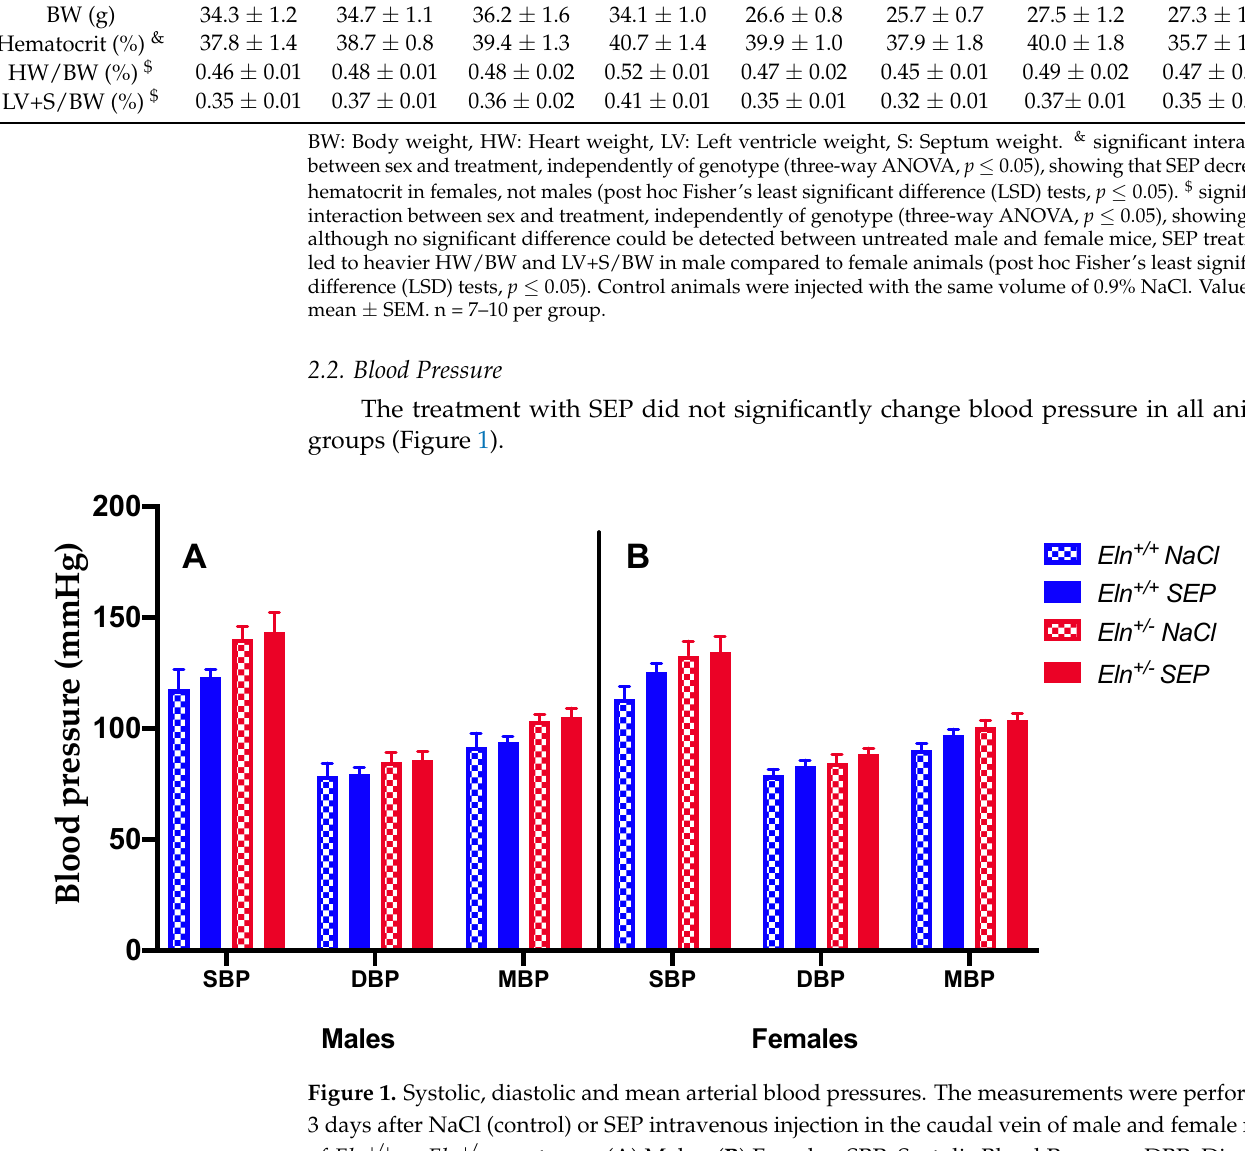
Treatment with SEP induced an elevation of the aortic outer (OD) and inner (ID) diameters in Eln +/+ , not Eln +/ ‐ , animals of both sexes (Figure 2A,B,D,E) and did not change the wall thickness in all groups (Figure 2C,F) compared to corresponding untreated mice .